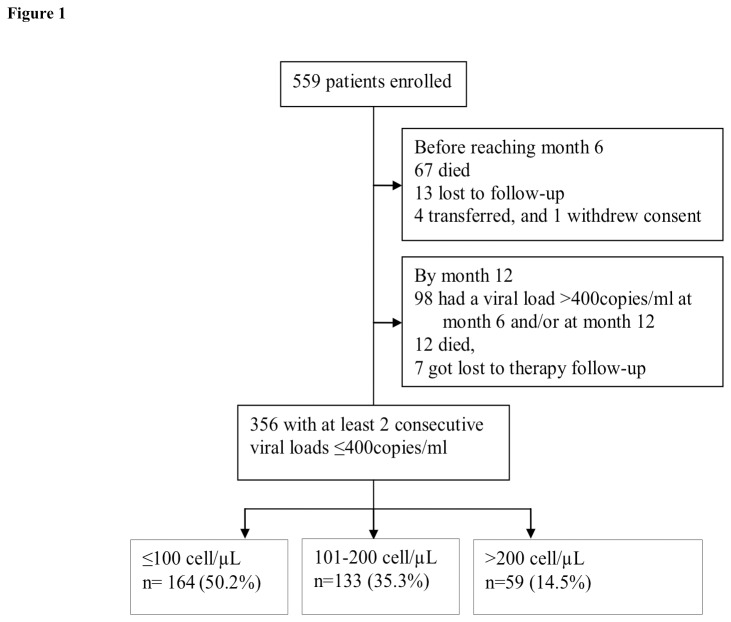
Study flow diagram.